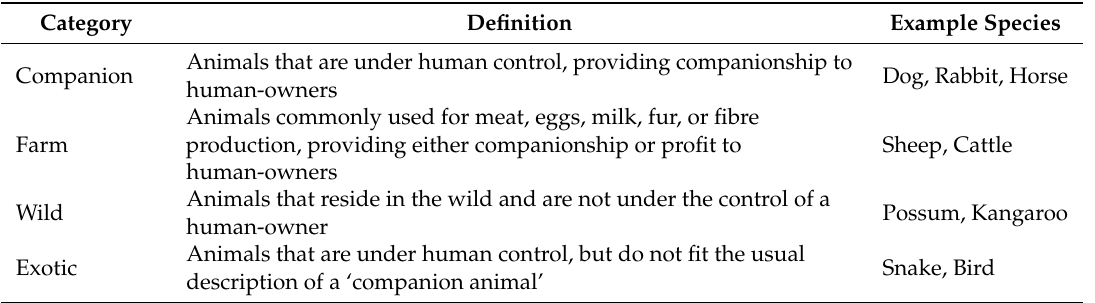
Table 3. Definitions and example of how species were categorized for the purposes of this study. Category Definition Example Species Animals that are under human control, providing companionship to Companion Animals commonly used for meat, eggs, milk, fur, or fibre Farm production, providing either companionship or profit to Animals that reside in the wild and are not under the control of a Animals that are under human control, but do not fit the Exotic